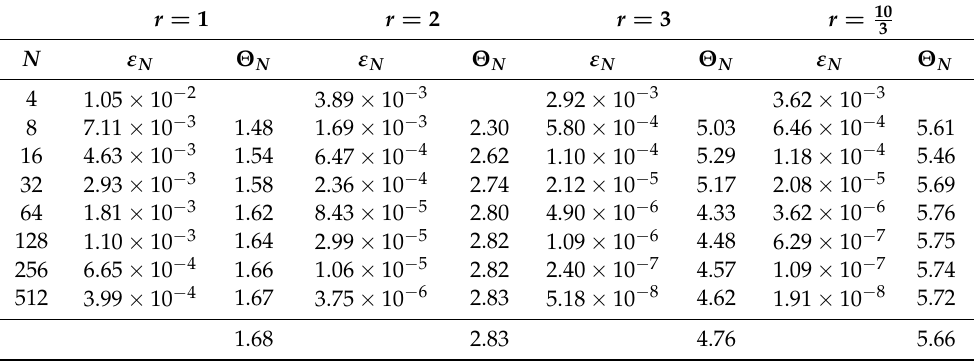
Table 1. Numerical results for problem (65) and (66) with m = 2.